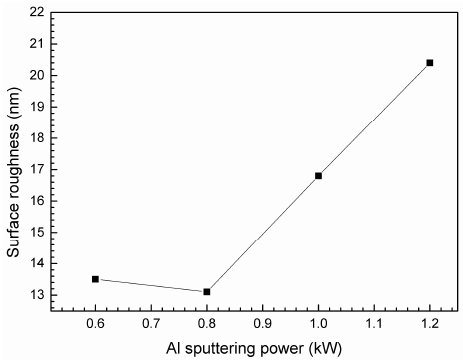
Figure 4. Surface roughness of the four CrAlSiN coatings deposited under different Al sputtering power.